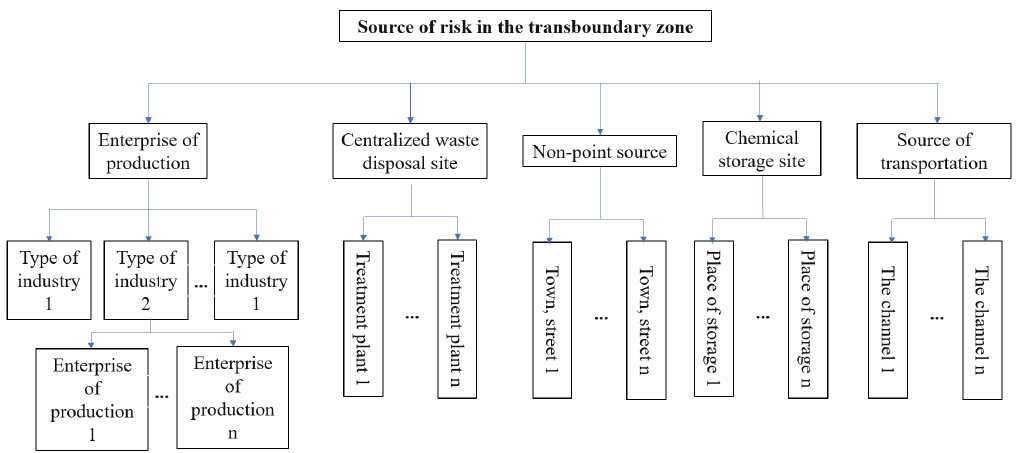
Figure 2. Classification of risk sources in the transboundary